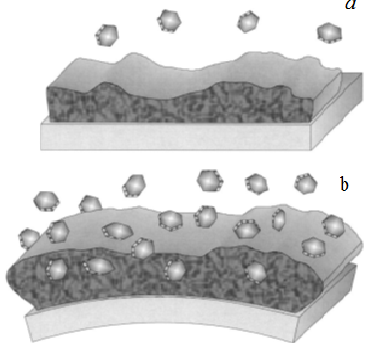
Figure 6. Sketch of the absorption-induced surface stress at the surface of cantilevers: ( a ) absorption and ( b ) penetration of target molecules into the sensing layer (reprinted from [38] with